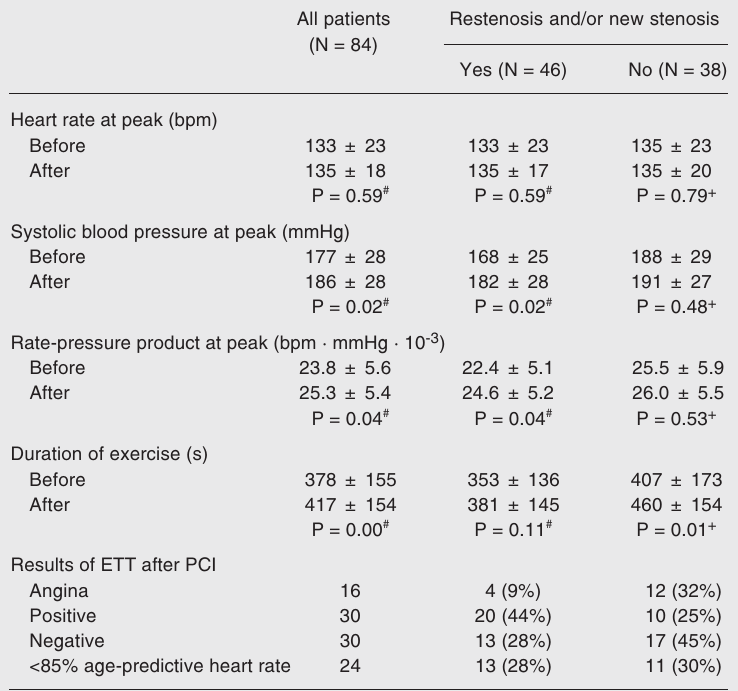
Table 3. Results of the exercise treadmill test (univariate profile analyses). All